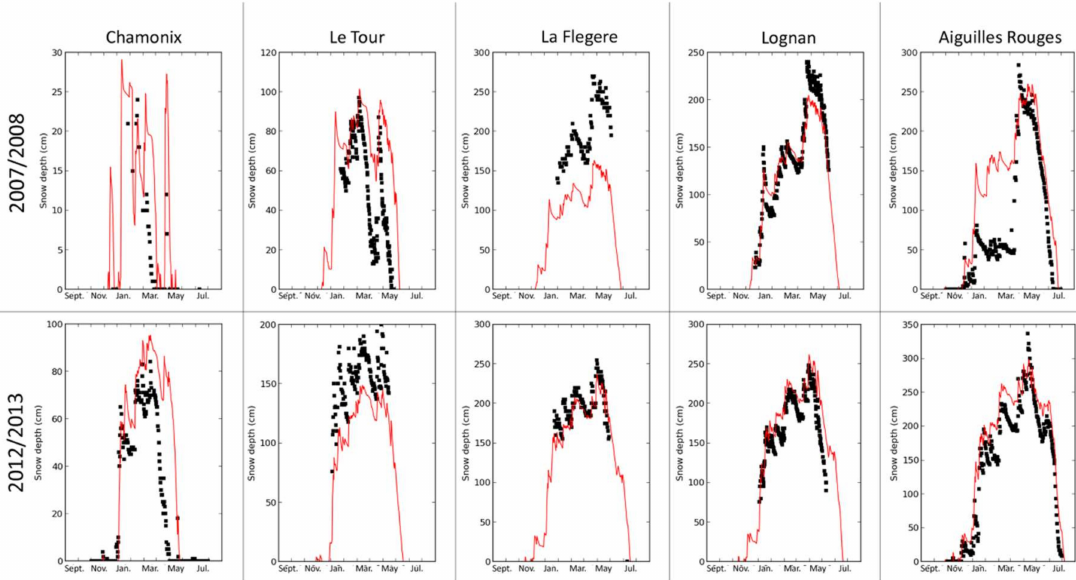
Figure 4. Observed (black squares) and simulated (red lines) snow depth evolution for the 2007–2008 (upper panel) and 2012–2013 (bottom panel) snow seasons. The elevations of the stations are: Chamonix: 1025 m.a.s.l.;